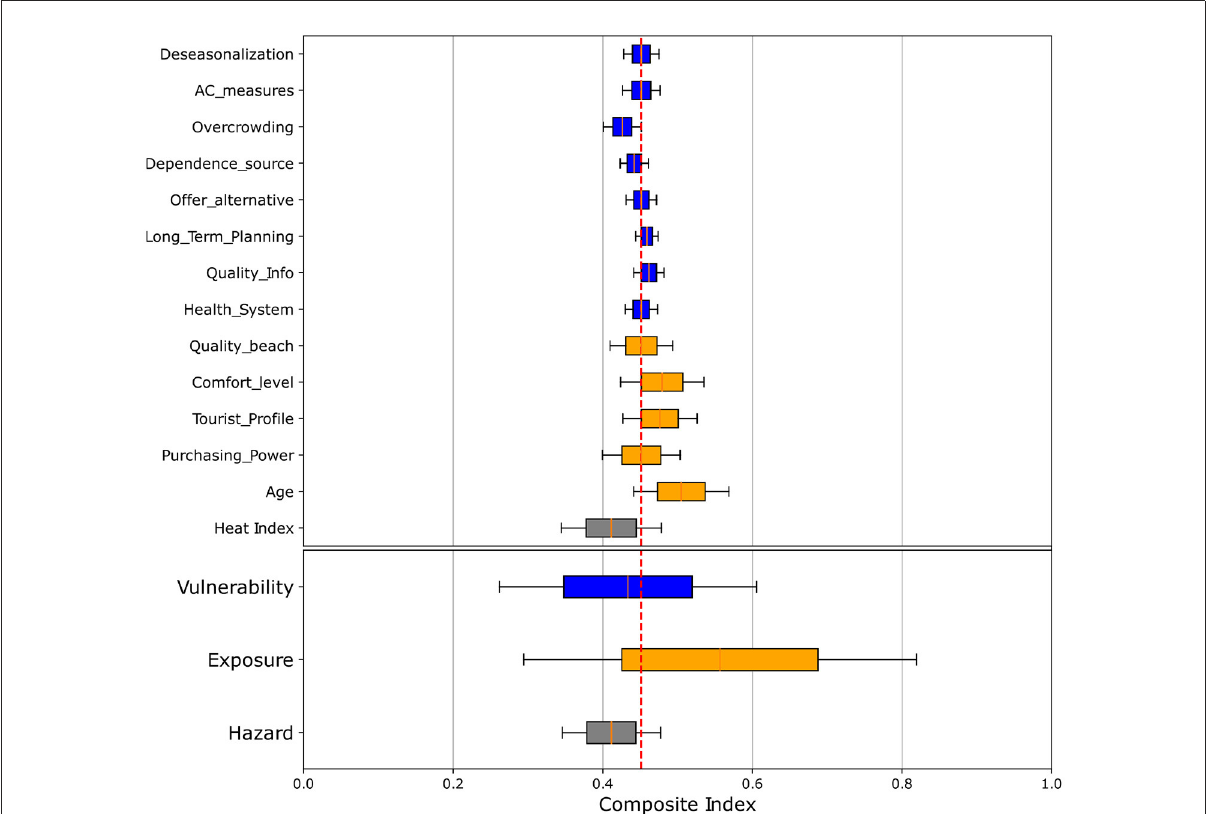
FIGURE6 Sensitivity of the final risk under future scenario SSP585 to different values of each indicator and the aggregated indicators. The vertical red line indicates the computed risk while the bars denote the range of risk values that could be obtained for the whole range of values of a given